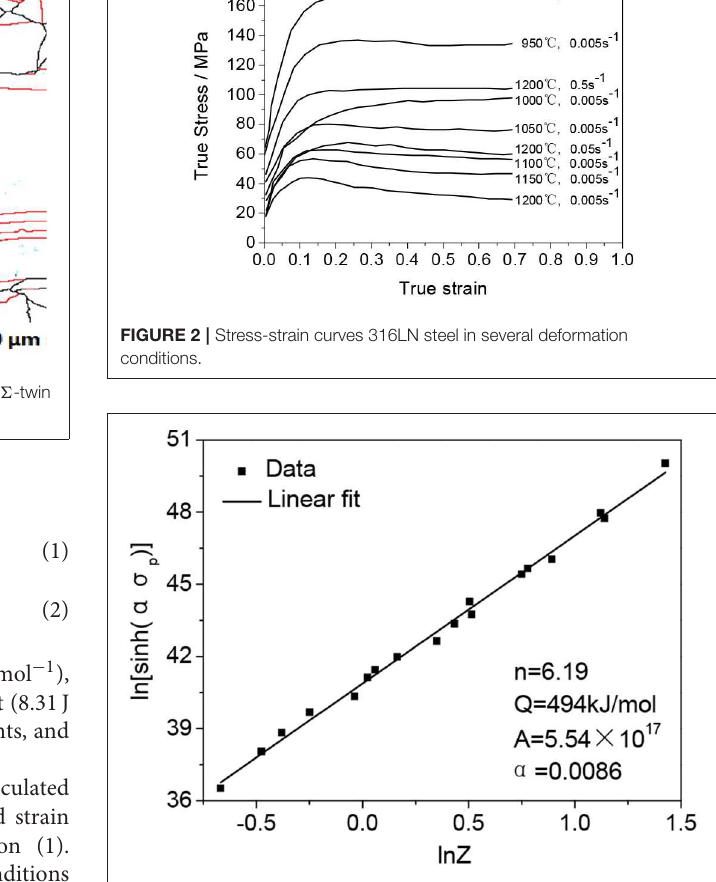
FIGURE 3 | The relationship between σ p and Z and the fitting curve with correlation coefficient of